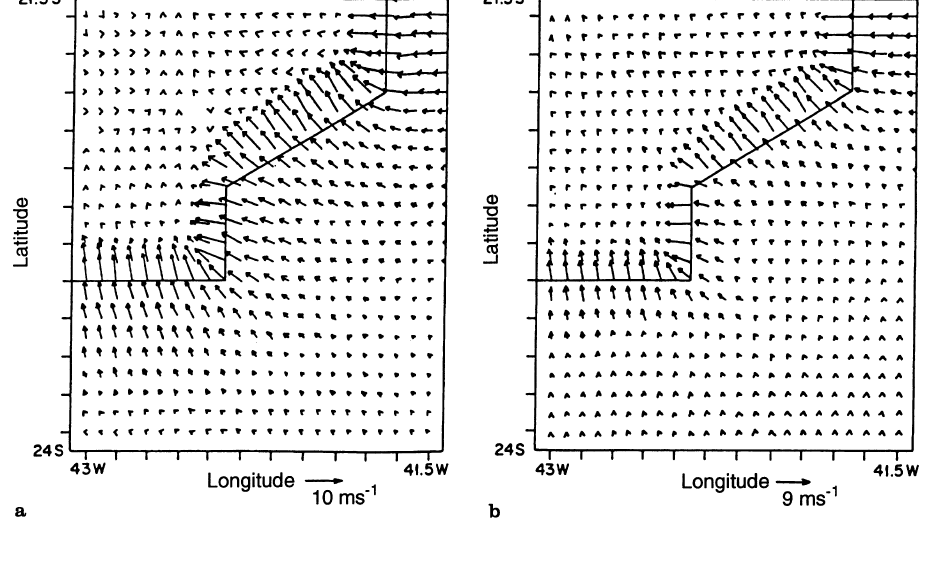
Fig. 9a,b. Simulated horizontal wind-vector (at level of 990 hPa) at 15:00 LT for: a OND and b AMJ. Units are m s (cid:255)